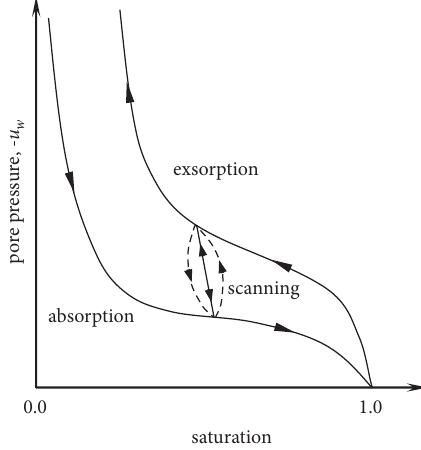
Figure 1: Typical absorption and exsorption behavior in unsaturated